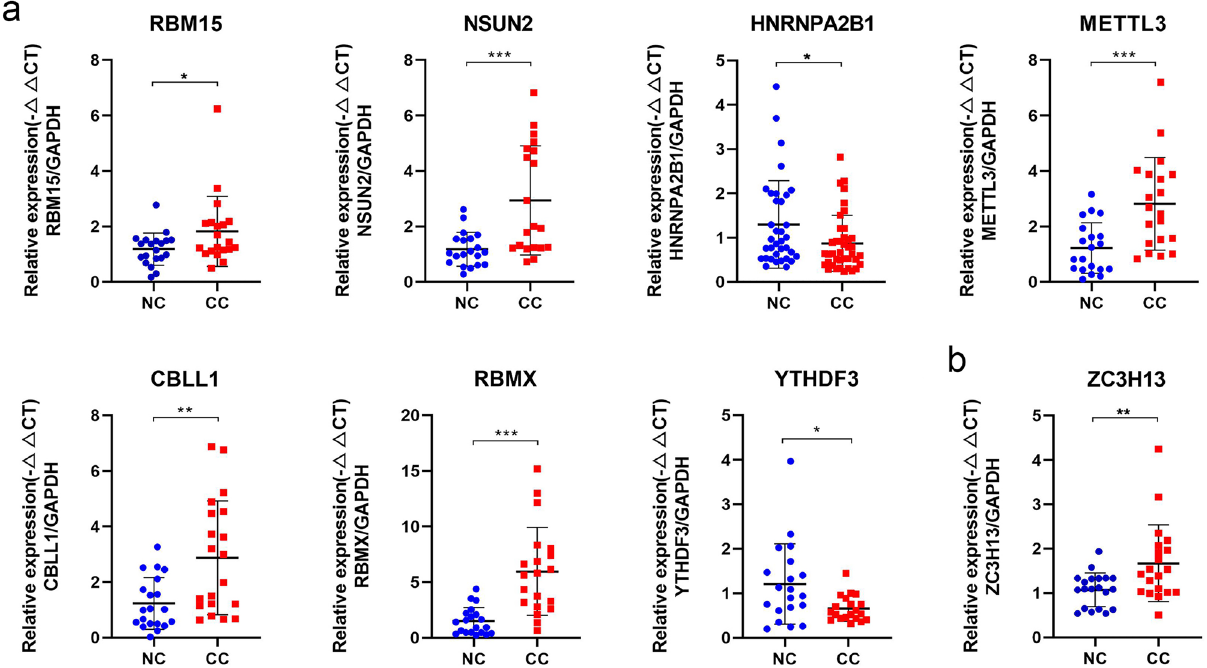
Figure 4. RNA expression detection of 20 pairs human cervical tissues using Real-time Quantitative PCR Detecting System. The expression comparison of RBM15, NSUN2, HNRNPA2B1, METTL3, CBLL1, RBMX, YTHDF3, and